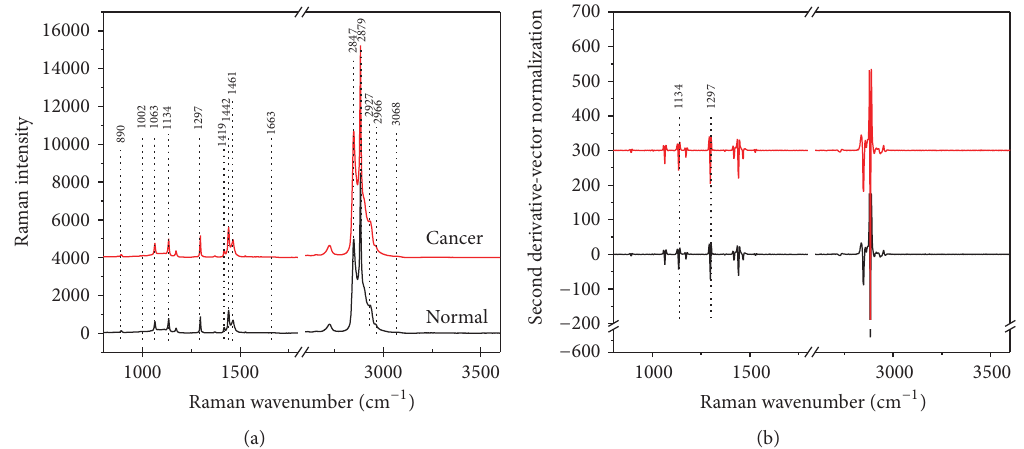
Figure 1: (a) Averaged Raman spectra for normal ( n = 78) and cancerous ( n = 81) colorectal tissues. (b) Second derivative-vector normalized spectra of Raman spectra from normal and cancerous tissues. The broken interval (-//-) indicates the region of 1800–2600 cm −1 , which does not contain tissue-related biochemical information.